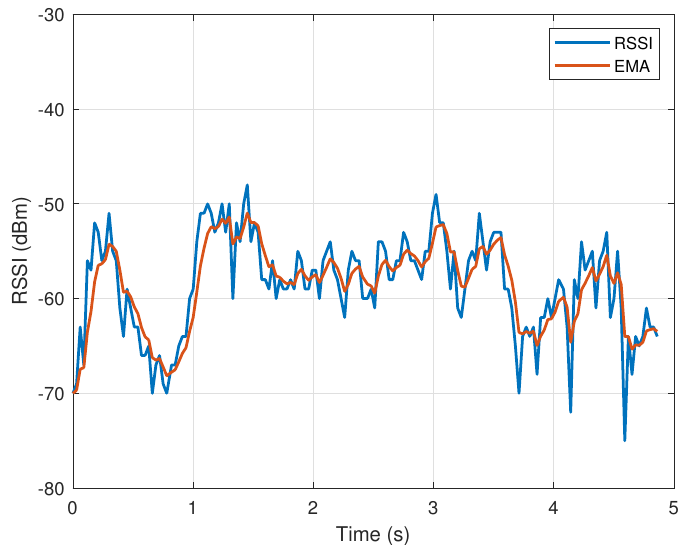
Figure 6. RSSI signal associated with elbow scratching. Blue line—RSSI measurements, red line— exponential moving average of measurements.